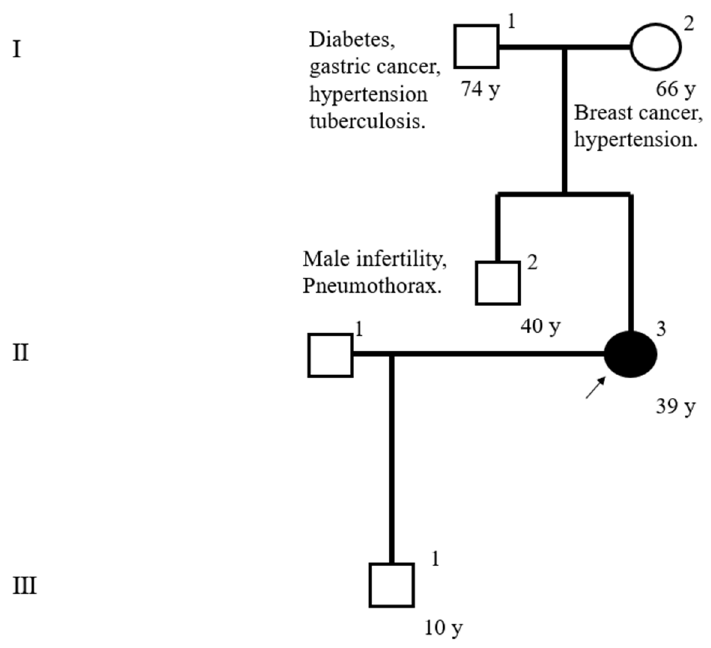
Figure 5. The patient’s pedigree. The patient’s brother was diagnosed male infertility. We performed a PCD gene panel, whole-exome sequencing, and Sanger sequencing as described previously [11], and identified the frameshift mutation c.1860_1861insCT (p.Ala621LeufsTer59) in SPEF2 in a homozygous state (Figure 6).